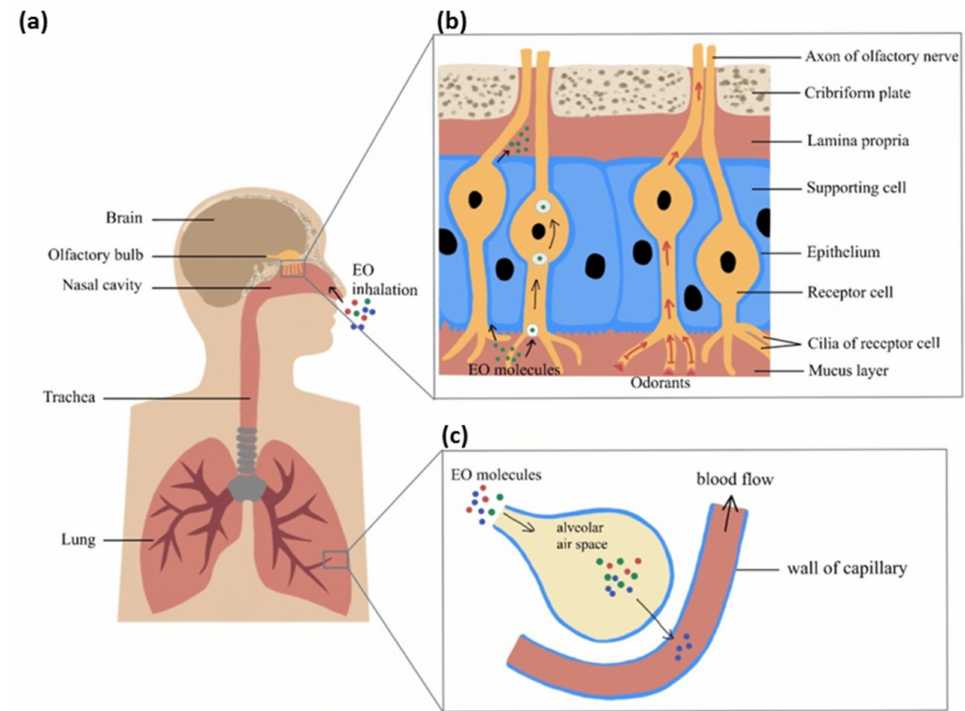
Figure 1. Inhaled EO response delivery to brain through the respiratory and olfactory systems: ( a ) Inhaled EO passes through the nasal cavity and reaches the olfactory system or respiratory system ( b ) Overview of EO molecules’ delivery pathway in the olfactory system ( c ) Overview of EO molecules crossing the air–blood barrier to reach the circulatory